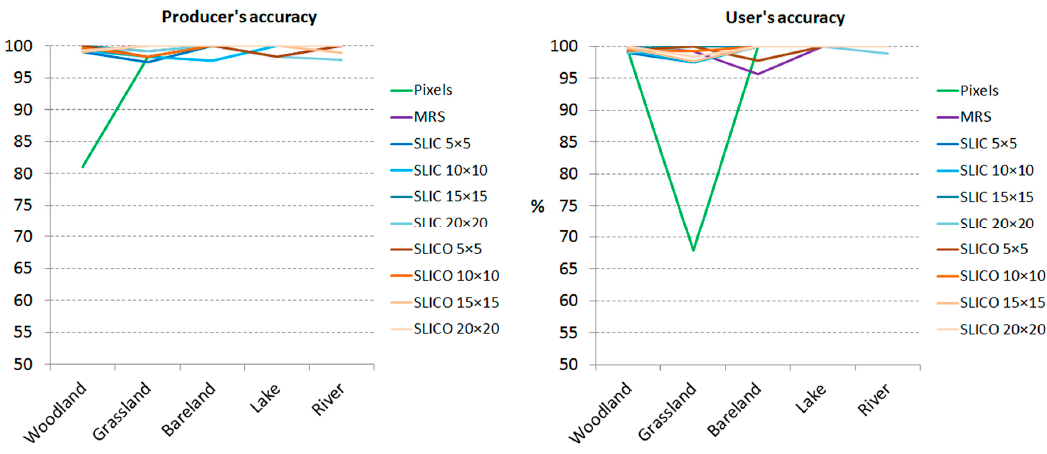
Figure 10. Producer’s and user’s accuracy for T3 RF classification results. Table 6. Overall accuracy (OA) and Kappa index for T2 and T3 RF classifications, using all ten approaches tested in this study.